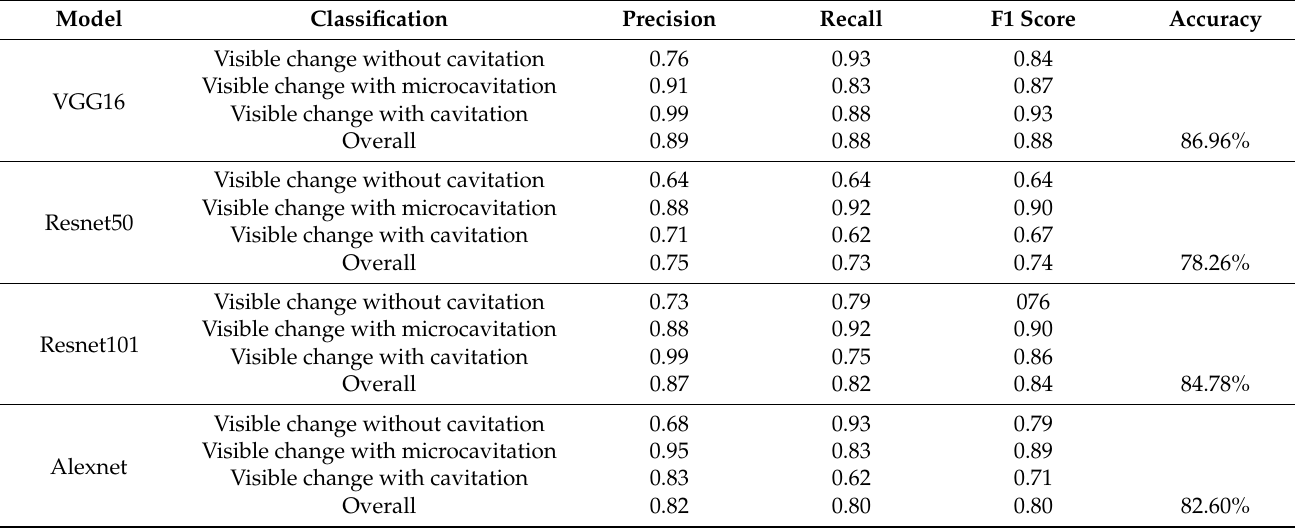
Table 3. Transfer learning model performance